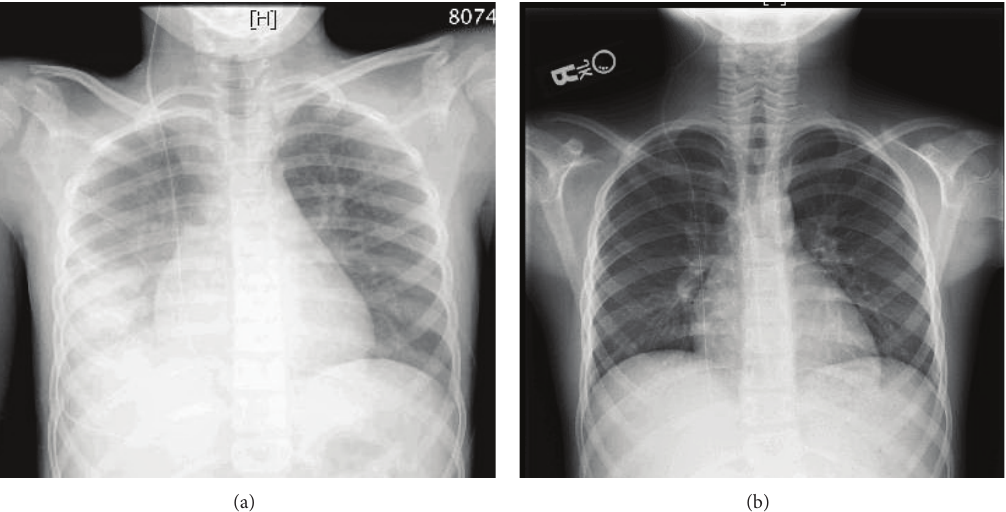
Figure 1: (a) CXR obtained immediately after nasogastric infusion of 283 mL of PEG in the right lung revealed right lower lobe opacities. (b) CXR 7 days after infusion showed significant clearance of right lower lobe